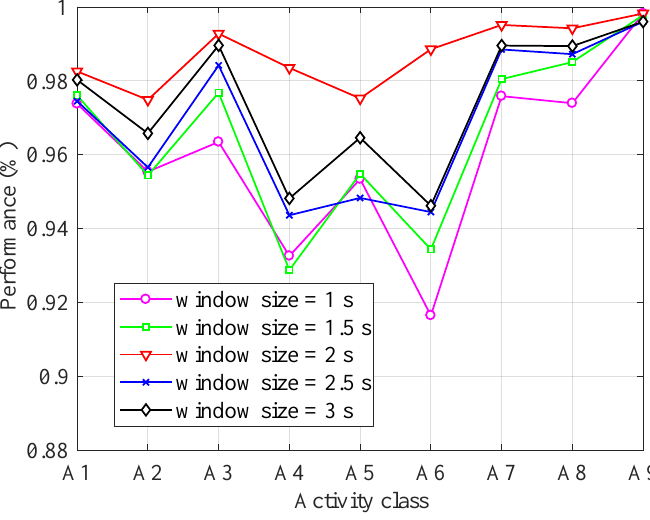
Figure 8. The performance with different window